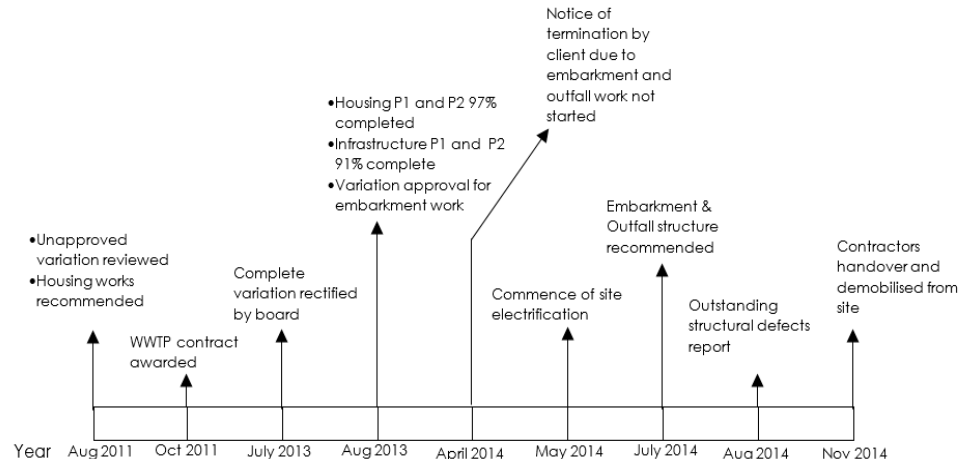
Figure 2. Timeline 2 for the period August 2011–November 2014.